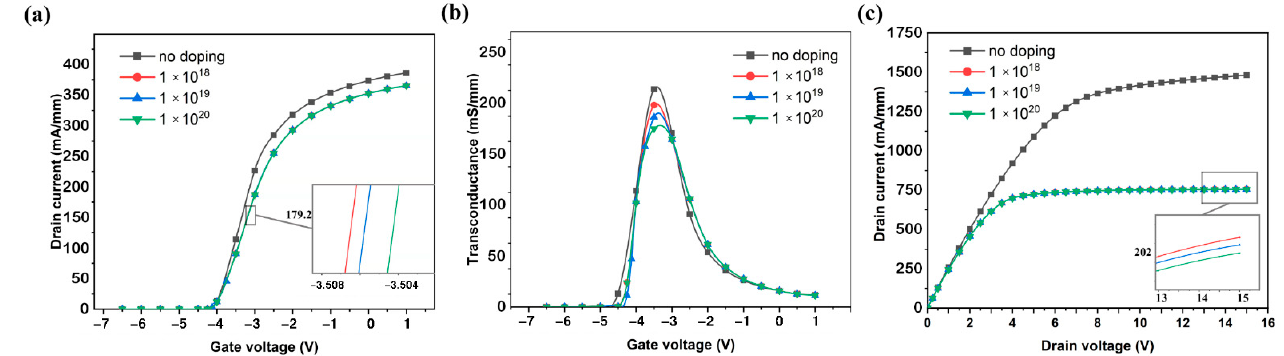
Figure 8. ( a ) Transfer characteristics, ( b ) transconductance, and ( c ) output characteristics of the HEMT of AlGaN buffer layer with different doping concentrations.